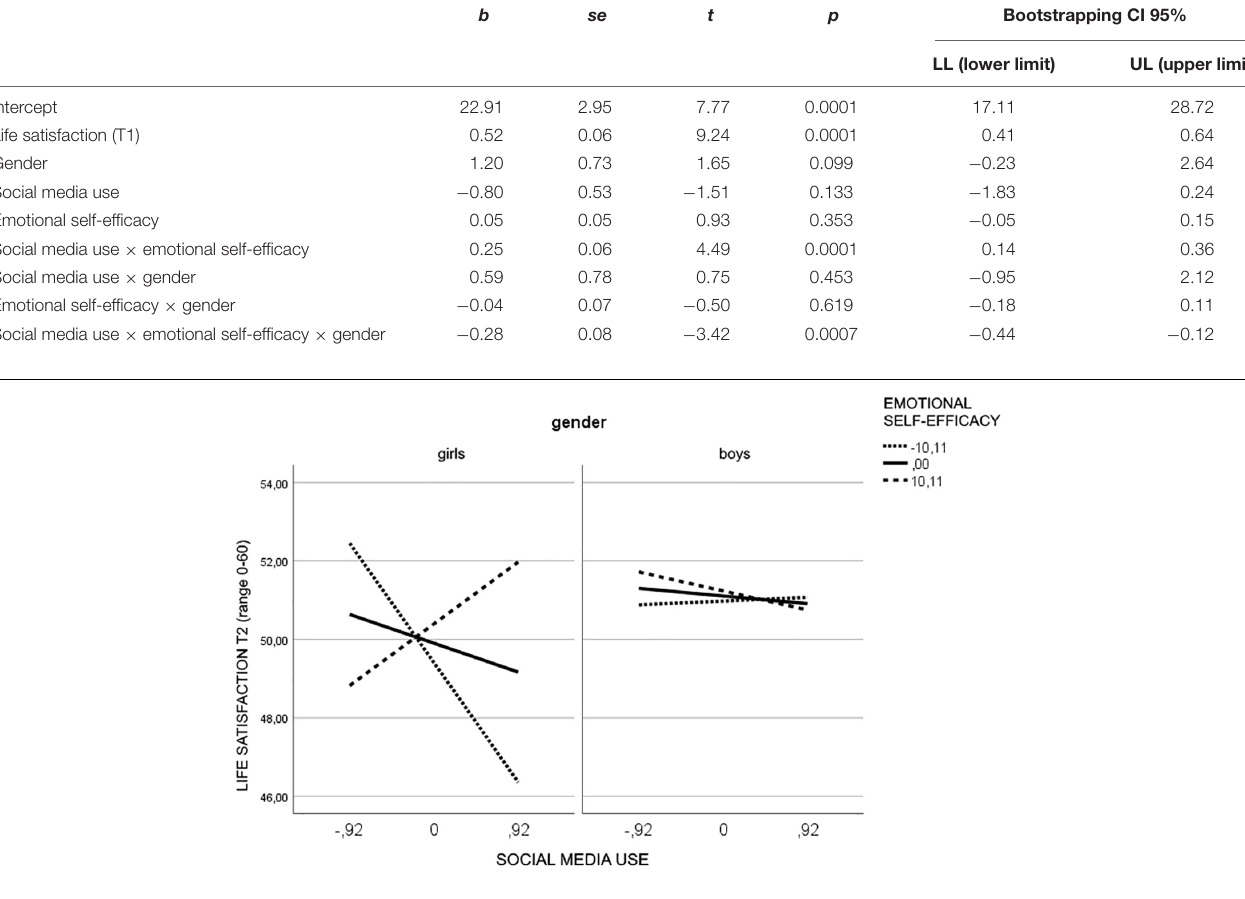
TABLE 5 | Predictors of life satisfaction (T2) (regression analysis).